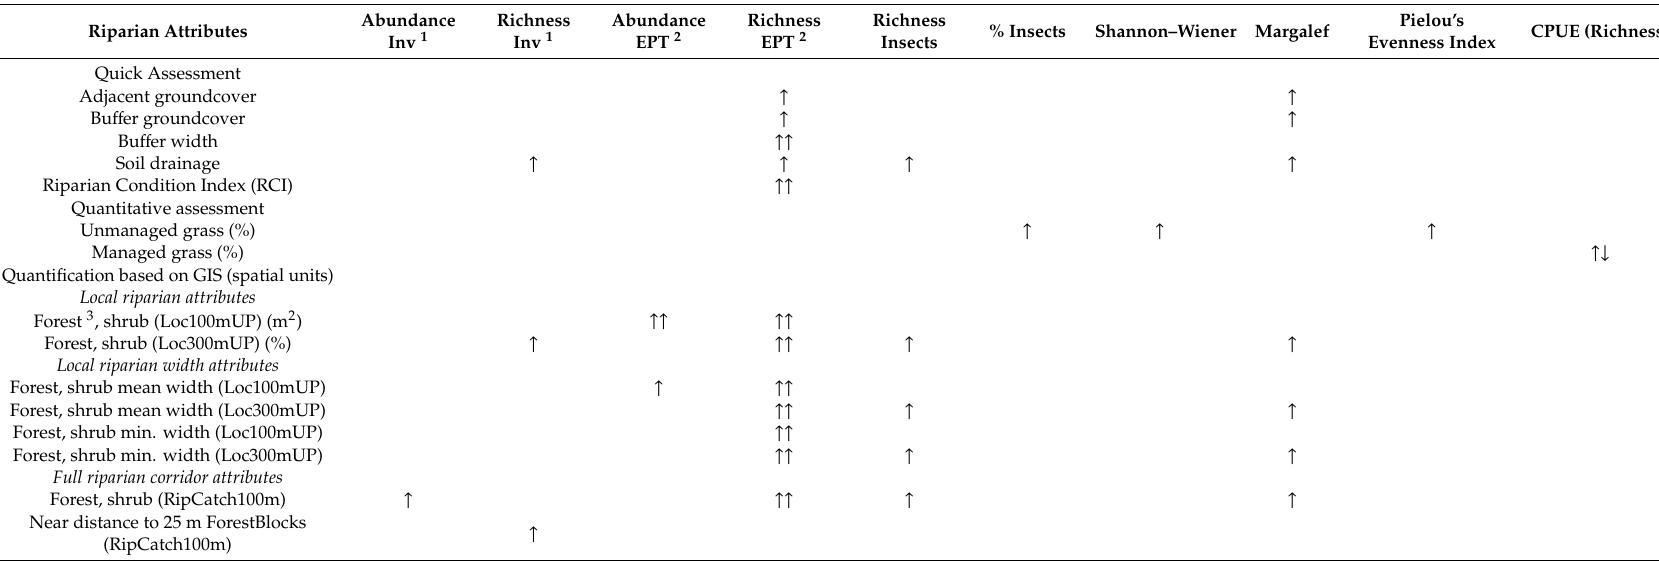
Table 3. Overview of associations between each riparian attribute and diversity metric obtained from the linear regression models. Only riparian attributes with significant associations are presented in the table. Black arrow represents statistically significant associations. Blue and red arrows indicate significant di ff erence of site type—least-disturbed sites and unbu ff ered sites—from the other site types, respectively. Upward and downward arrows signify positive or negative associations, respectively. Graphical representations of selected models are presented in Figure 3 and Figure S3. The p -values are presented in Table